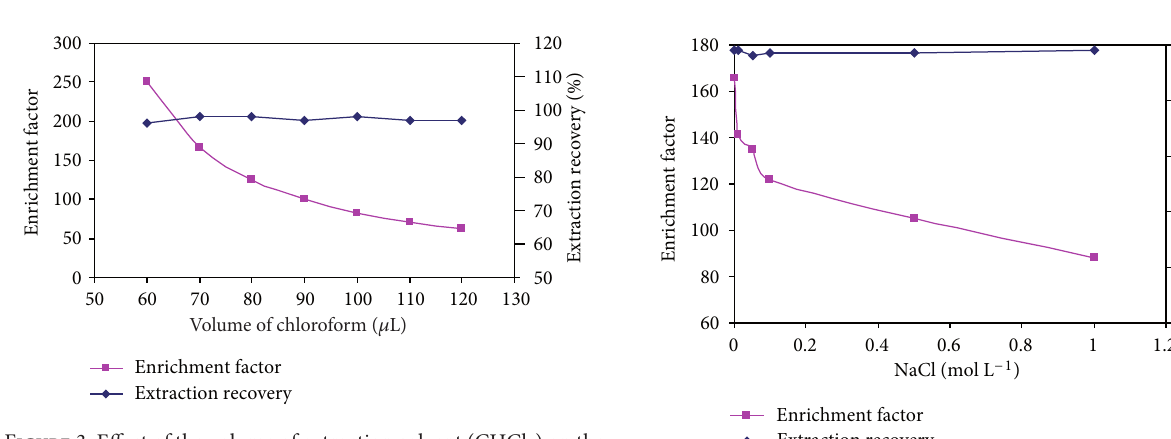
F 3: Effect of the volume of extraction solvent (CHCl enrichment factor and extraction recovery of palladium obtained